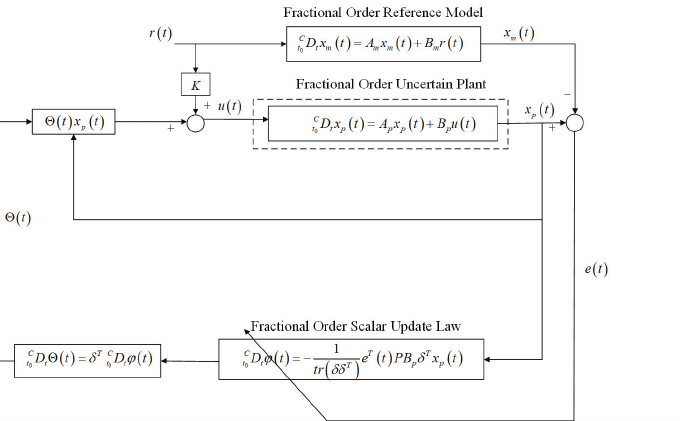
Figure 1. Visualization of the adaptive control framework with the fractional-order scalar update